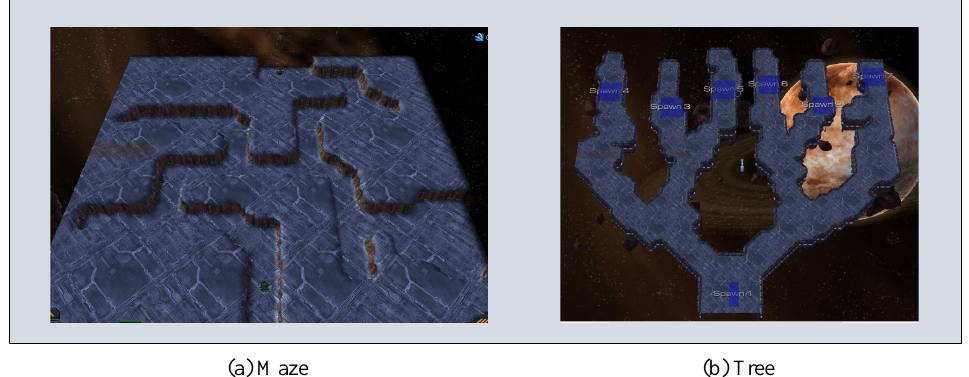
Figure 5. Starcraft II